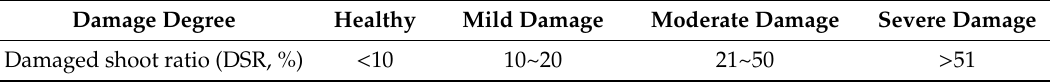
Table 2. Main parameters of the UHD S185 (provided by the manufacturer).